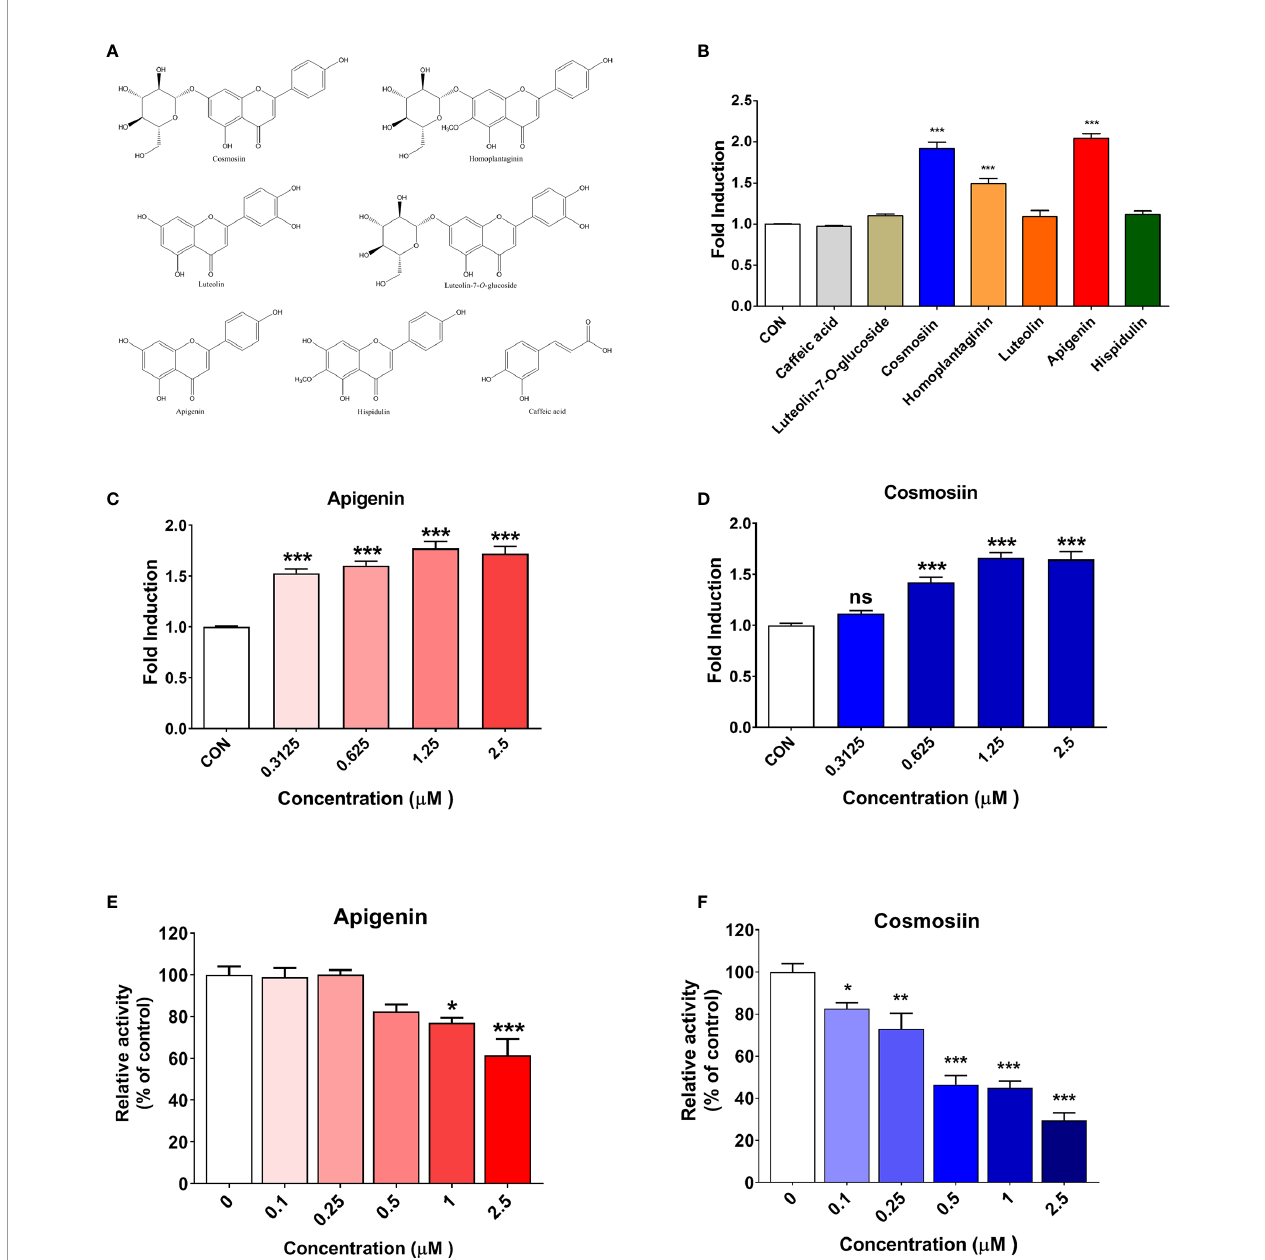
FIGURE 3 | PD-1/PD-L1 interaction blockade and T-cell activation enhancement by SPE components in vitro . (A) Chemical components of SPE. (B) The ability of seven components from SPE to enhance T-cell functional activity was assessed using a PD-1/PD-L1 blockade bioassay. These seven components were used at a concentration of 2 µM. (C, D) A PD-1/PD-L1 blockade bioassay was performed to measure the inhibitory activity of apigenin and cosmosiin. PD-L1 aAPC/CHO-K1 cells were plated and incubated at 37°C for 20 h prior to the addition of PD-1 effector cells and increasing concentrations of apigenin or cosmosiin. (E, F) Competitive ELISA was performed using a PD-1/PD-L1 inhibitor ELISA-binding assay after treatment with the indicated concentrations of (E) apigenin and (F) cosmosiin. Bar graph (mean ± standard error of the mean) statistics were determined with data of three experiments, using one-way ANOVA with Tukey ’ s post- hoc test; ***P < 0.001, **P < 0.01, *P < 0.05, n.s, not signi fi cant, compared with the